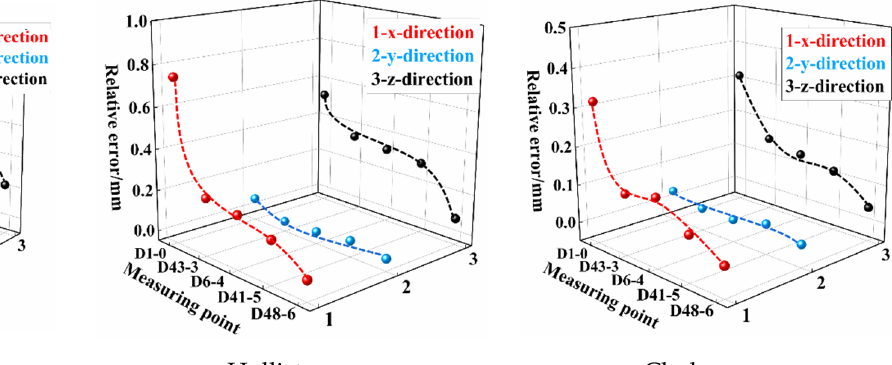
Figure 16. Relative errors of peak displacement between the two models.